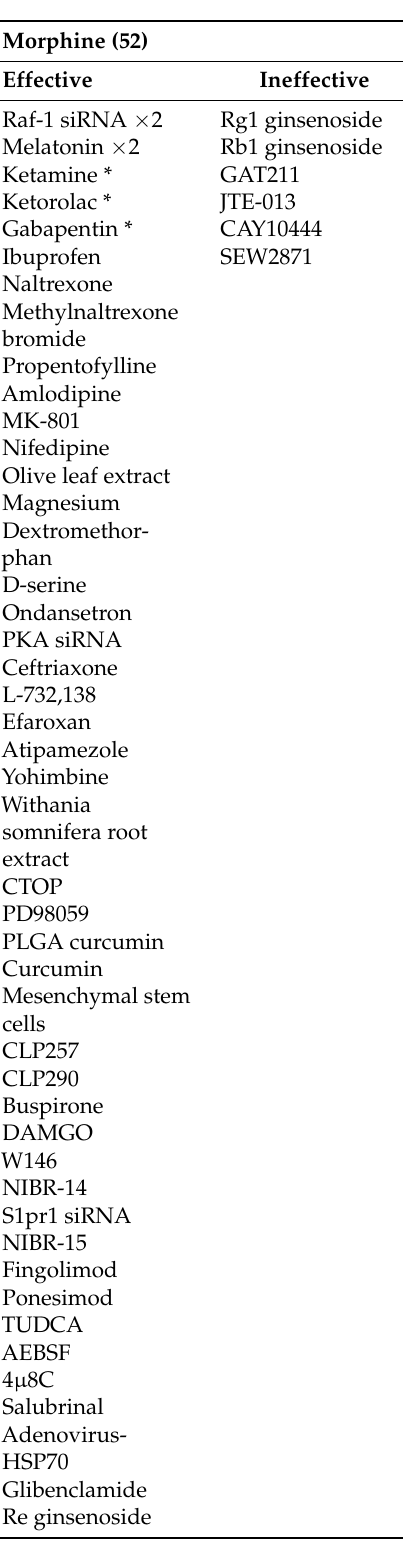
Table 4. Interventions studied for each type of opioid. Remifentanil trials investigated 27 interven- tions, fentanyl trials investigated 9 interventions, and morphine trials investigated 52 interventions. An intervention is listed as “ineffective” if none of the tested doses were different from the control. *: the intervention is studied for the other opioids